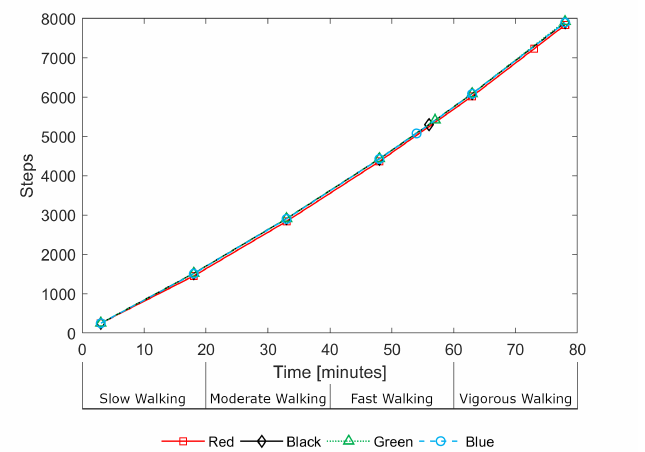
Figure 7. Inter-instrument ICC values for 12 h of everyday living.